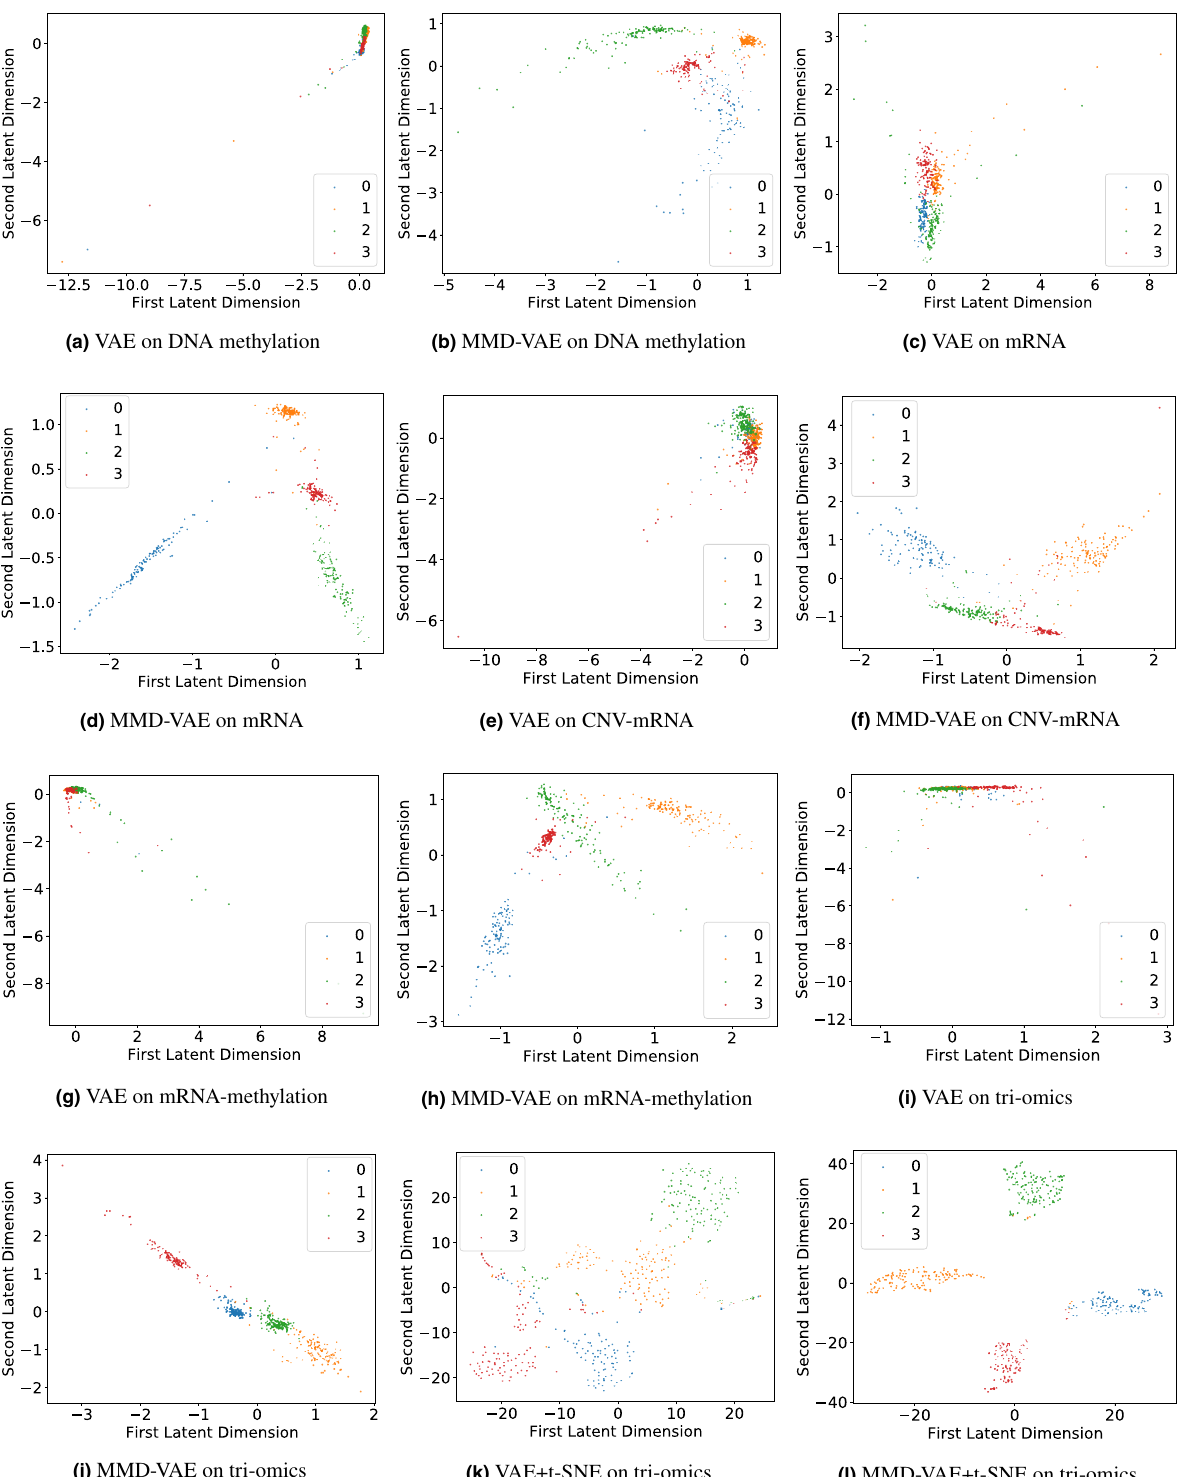
Figure 3. Clustering molecular subtypes using the LFs learned through the supervised VAE & MMD-VAE + t-SNE (2D or 2 LFs): ( a – c ) for MMD-VAE respectively for mono-omics, di-omics and tri-omics data, ( d – f ) for MMD-VAE + t-SNE respectively for mono-omics, di-omics and tri-omics data. Legends: 0—Immunoreactive, 1—Differentiated, 2—Proliferative and